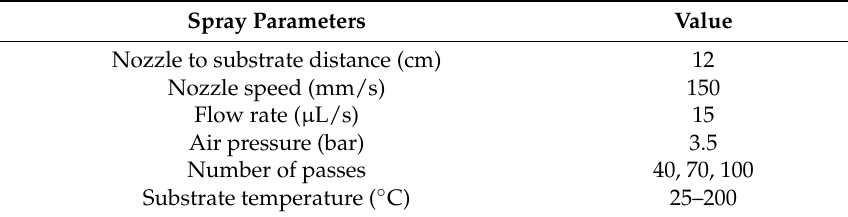
Table 1. Spray coating parameters for the fabrication of perovskite